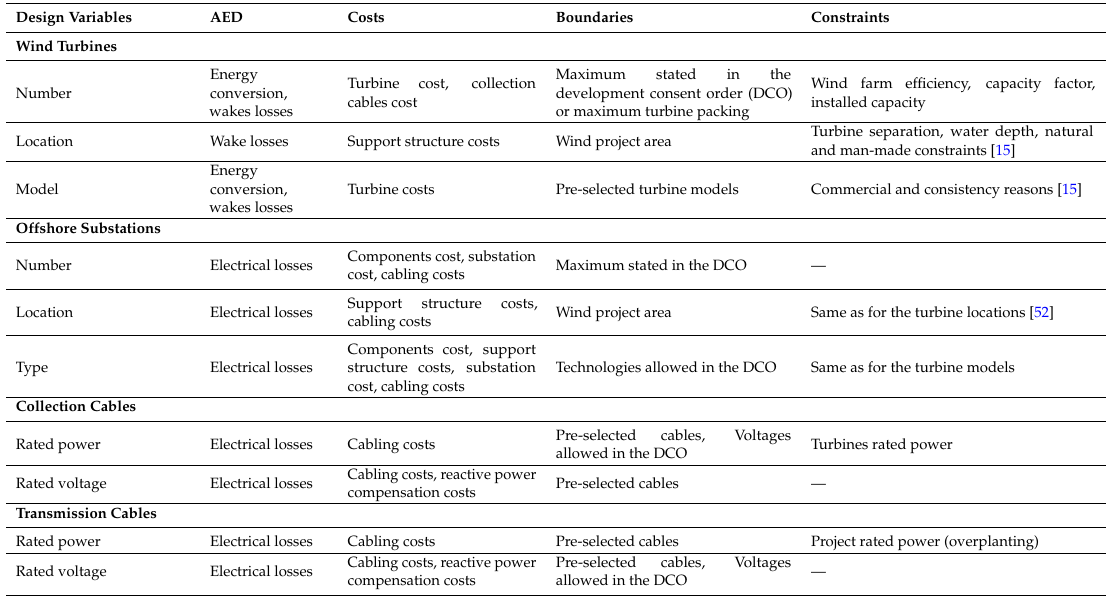
Table 4. Design variables: influences, boundaries and